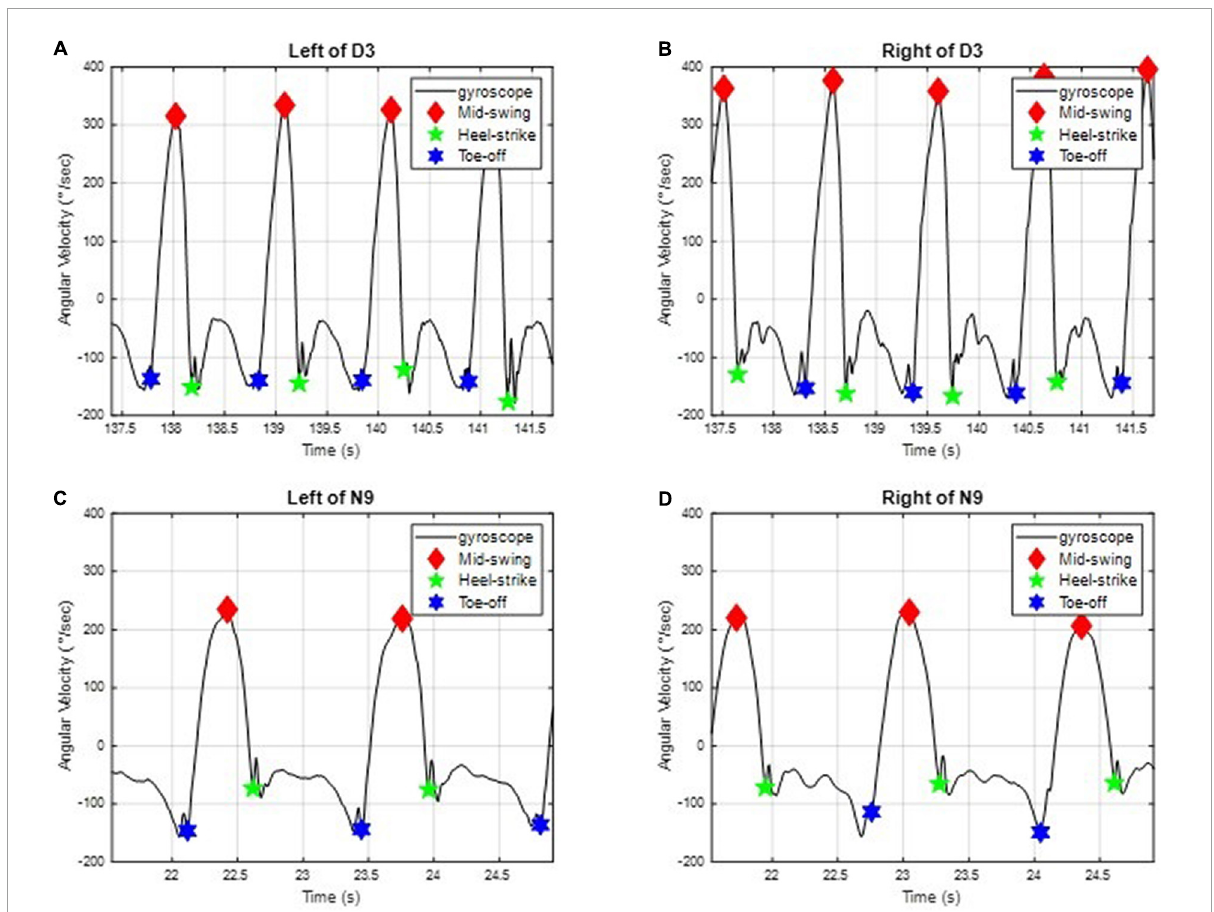
FIGURE2 The angular velocities of D3 and N9 of the shank on the sagittal plane. The important gait events, such as the mid-swing, the heel strike, and the toe-off, are marked. (A) On the left leg of D3. (B) On the right leg of D3. (C) On the left leg of N9. (D) On the right leg of N9.